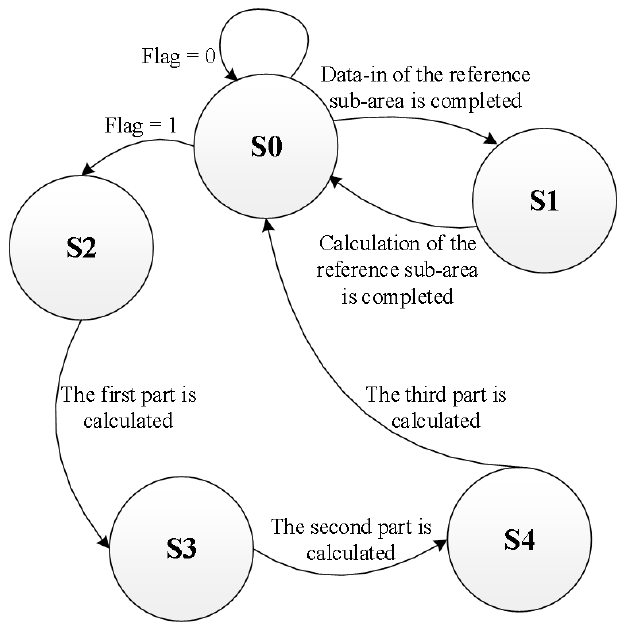
Figure 18. State machine that controls time-sharing